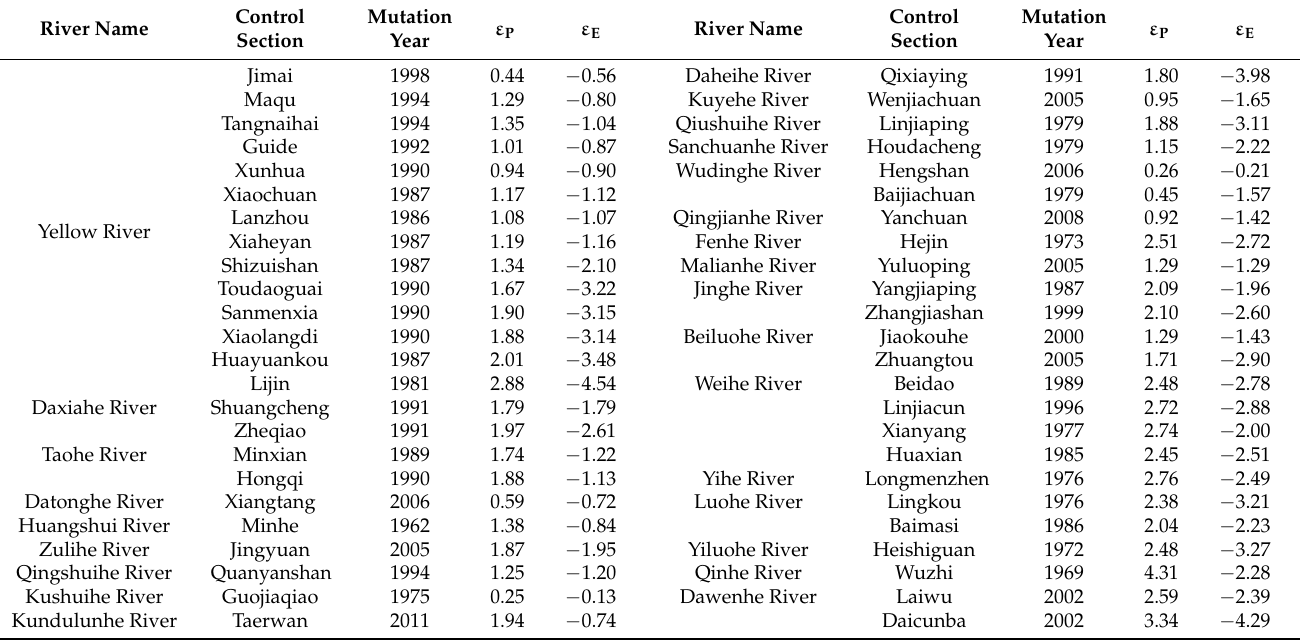
Table 5. Climatic elasticity coefficient of main control sections in the Yellow River